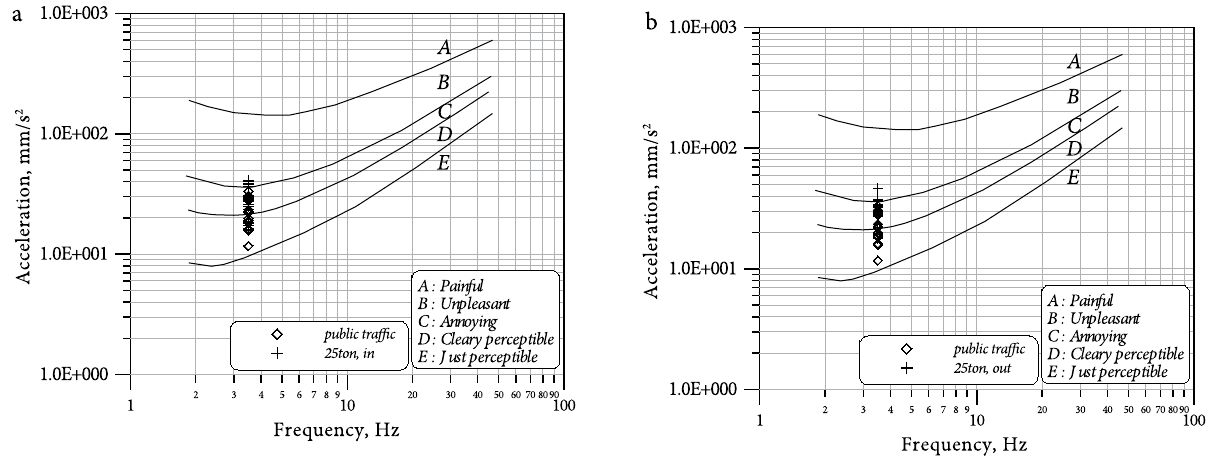
Fig. 11. Comparison with public traffic and test-vehicle (acceleration): a – in; b – out